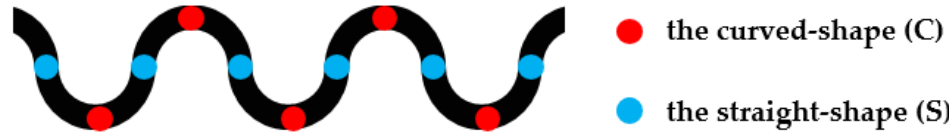
Figure 2. The position of the measured area of curved-shape (C) and straight-shape (S).